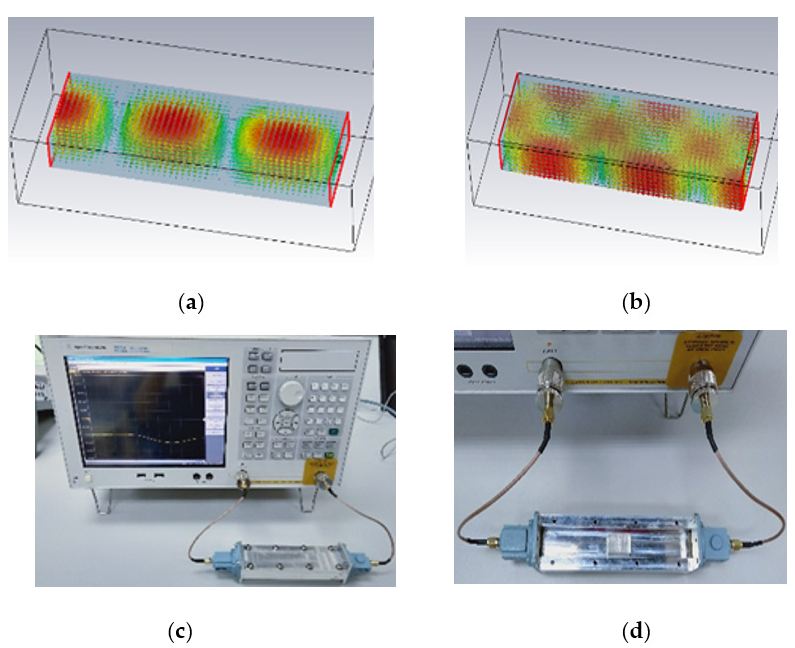
Figure 6. Waveguide technique for solid PDMS-Ferrite dielectric characteristic measurement; ( a ) strong electric filed at the waveguide center, ( b ) strong magnetic field at the waveguide wall, ( c ) measurement setup using waveguide technique, and ( d ) sample location for testing within the waveguide.